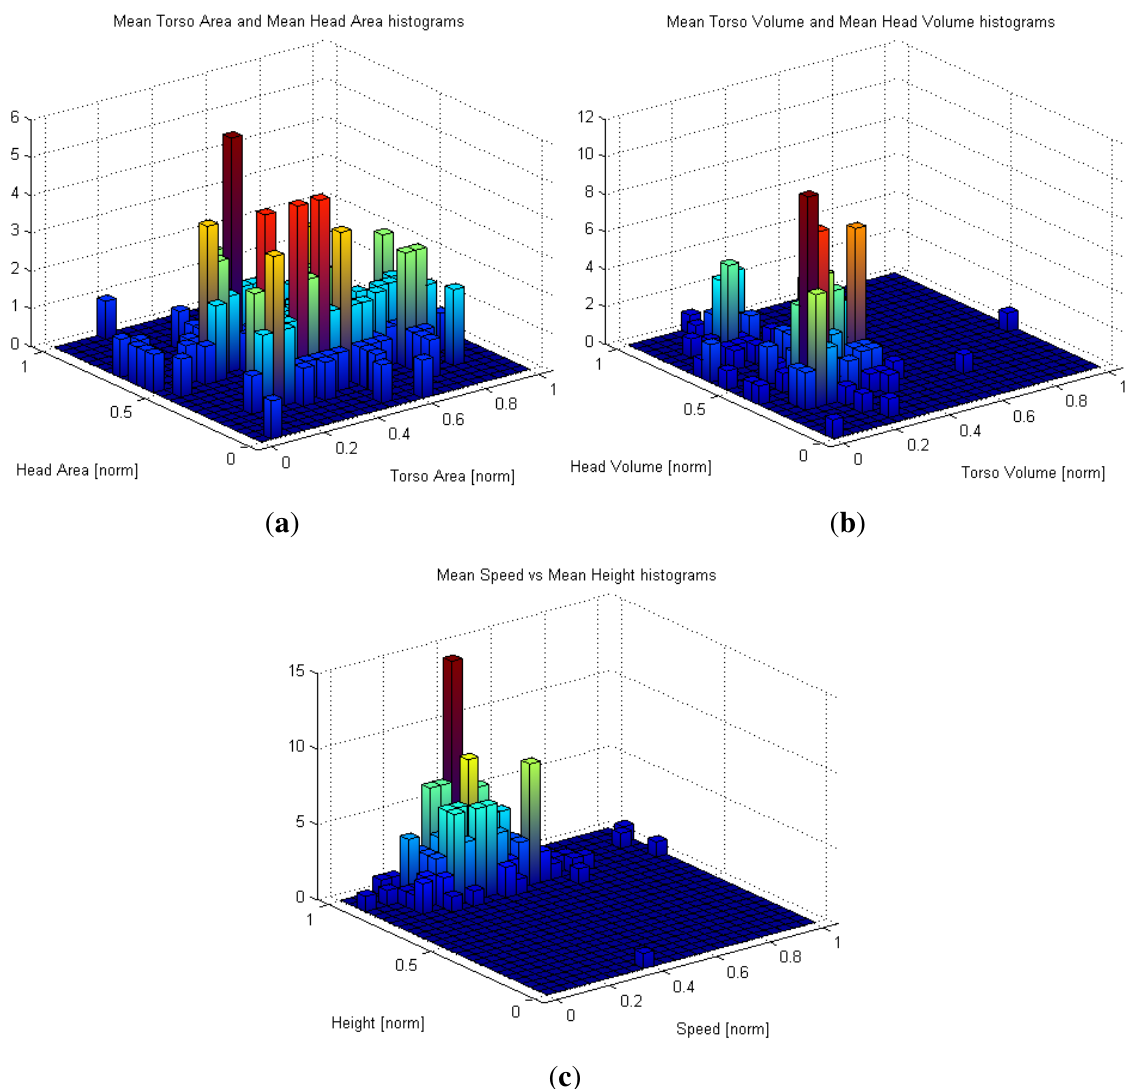
Figure 8. Normalized projection of ( a ) the area features; ( b ) the volume features; and ( c ) the speed and height features for the analyzed